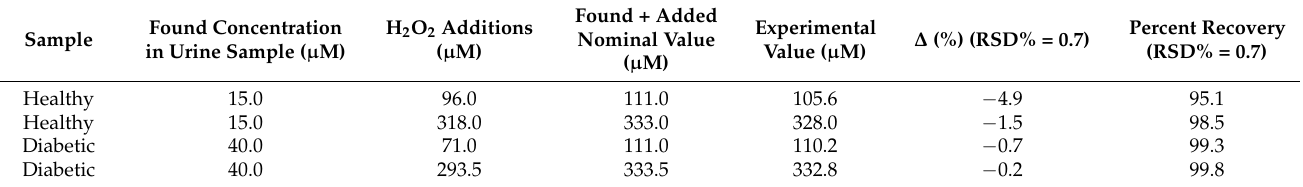
Table 5. Experimental percentage recovery for hydrogen peroxide addition in healthy and diabetic urine samples. The reported found and added concentration values are the final ones obtained after dilution of the